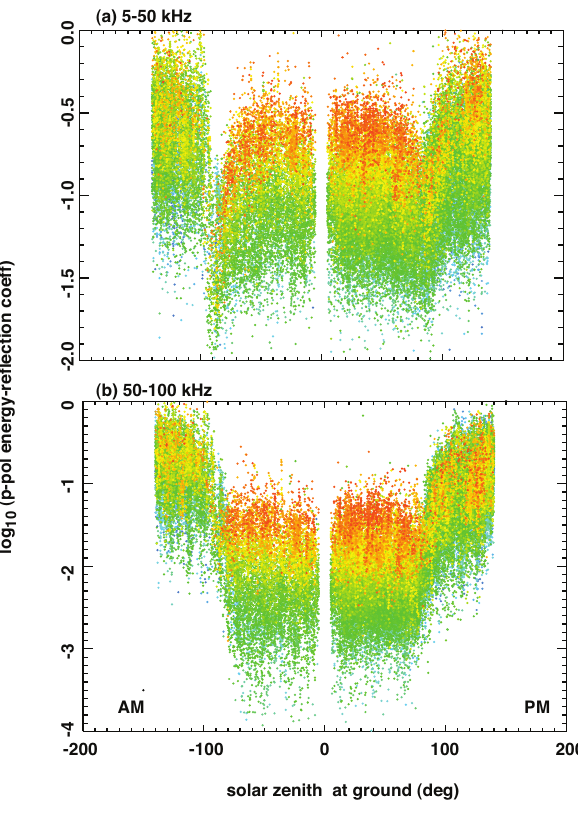
Fig. 5. log 10 (energy reflectivity) vs. solar zenith angle. The iono- spheric angle of incidence θ i , averaged over both echoes, is coded in color from 50 deg (blue) to 74 deg (red).